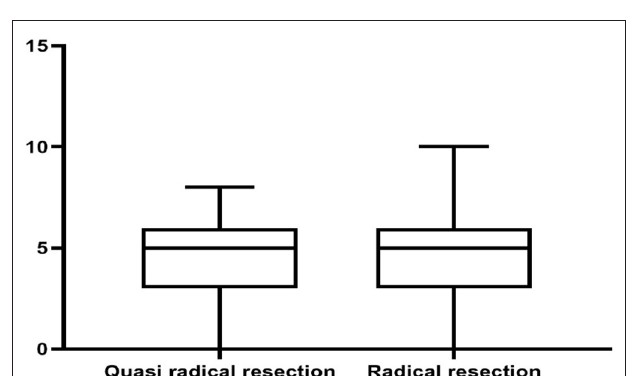
FIGURE 6 | Social relations domain. *Indicates statistical differences between the two groups.